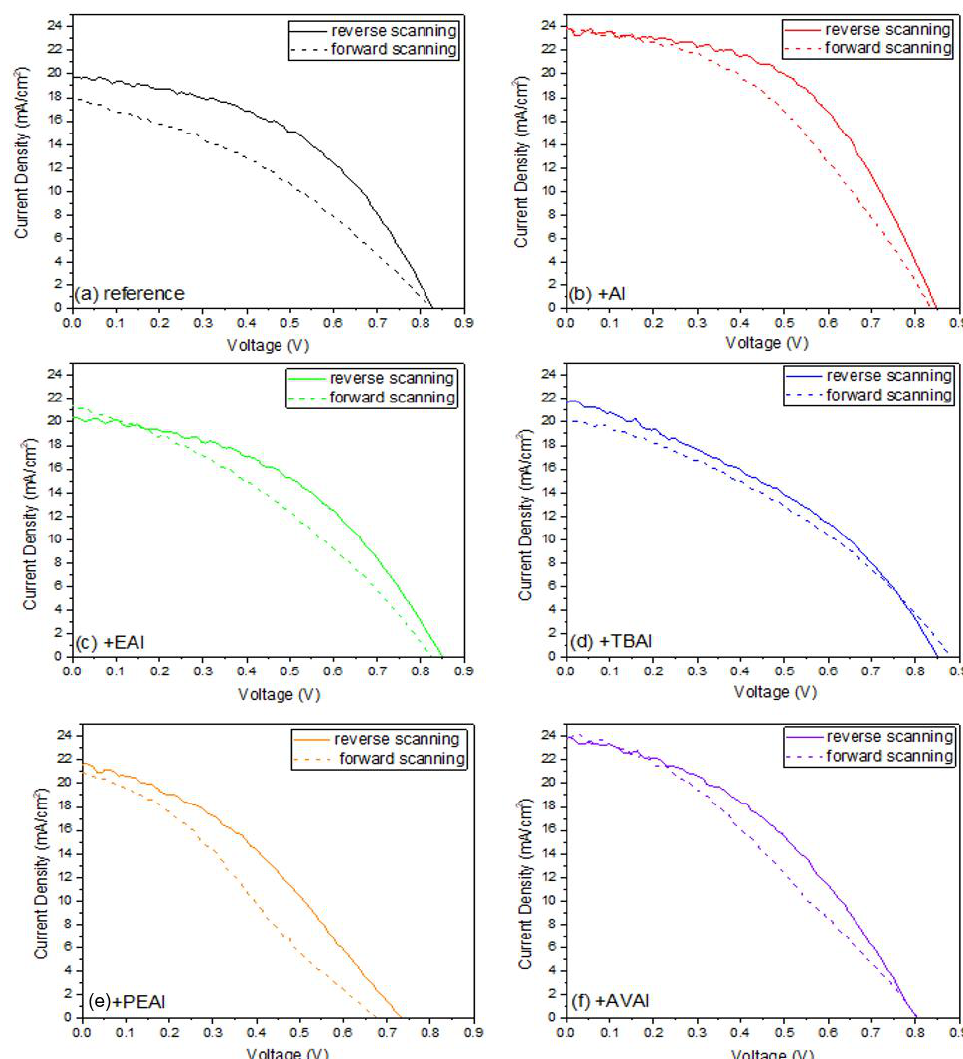
Figure 5. The J-V curves of the C-PSCs prepared with each perovskite under study ( a ) reference; ( b ) ammonium iodide additive; ( c ) ethyl ammonium iodide additive; ( d ) tetra butyl ammonium iodide additive; ( e ) phenethyl ammonium iodide additive; and ( f ) 5-ammonium valeric acid iodide. Table 2. Summary table of the Hysteresis Index (HI) that has been calculated for each one of the C- PSCs under study.